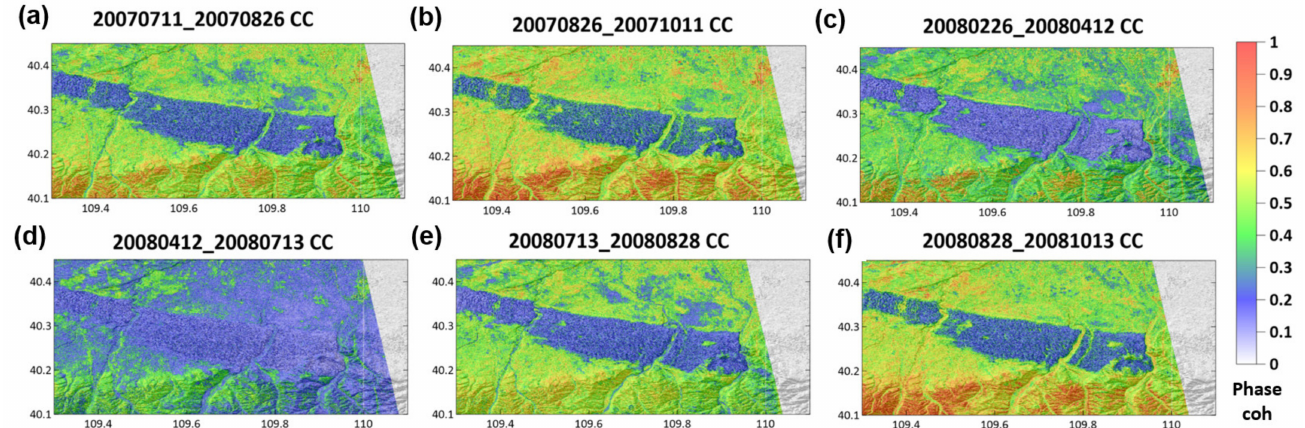
Figure 3. Interferometric Synthetic Aperture Radar (InSAR) phase coherence using PALSAR-1 during the 2007–2008 period, including ( a ) 11 July 2007–26 August 2007, ( b ) 26 August 2007–11 October 2007, ( c ) 26 February 2008–12 April 2008, ( d ) 12 April 2008–13 July 2008, ( e ) 13 July 2008–28 August 2008, and ( f ) 28 August 2008–13 October 2008. Note the dust storm season is usually from February to May, but mainly in March and